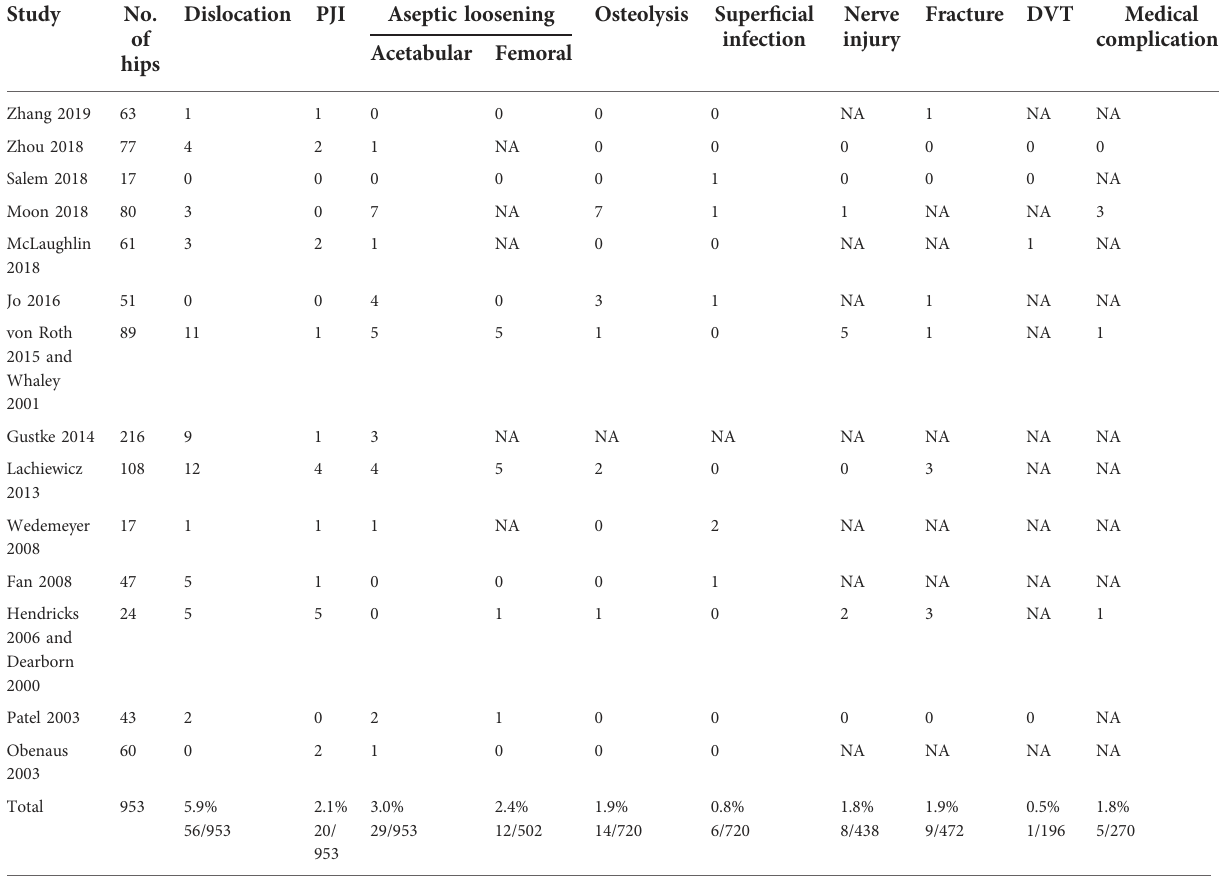
TABLE 4 Summary of